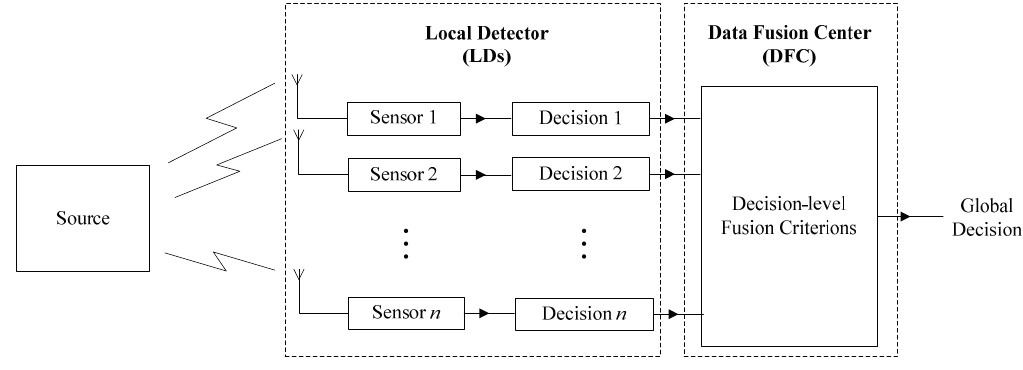
Figure 2. Distributed detection system with decision-level fusion